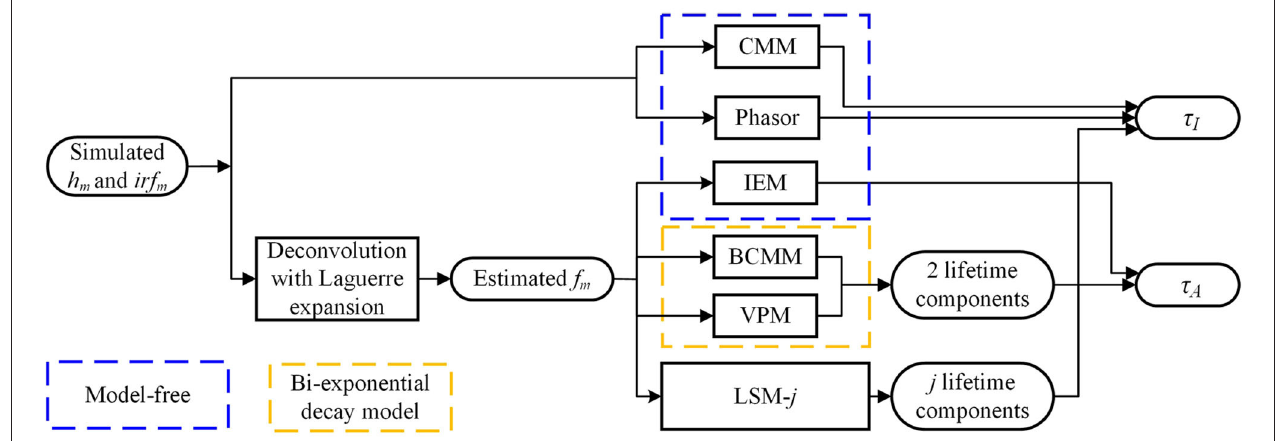
FIGURE 2 | Flow diagram for τ I and τ A